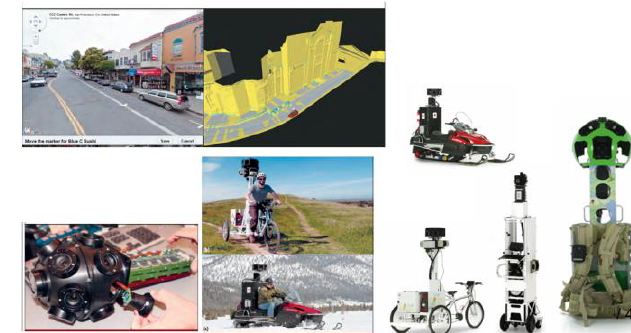
Figure 8. Google street view and panoramic image acquisition